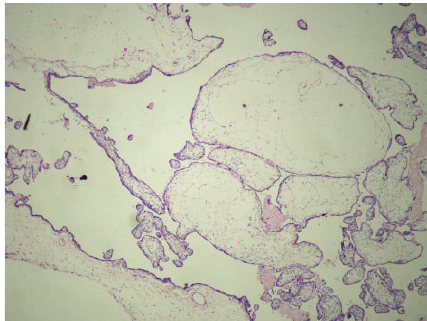
Figure 6: Photomicrograph showing large, edematous stem villi without trophoblastic proliferation. Hematoxylin and eosin stain. Original magnification ×10 .